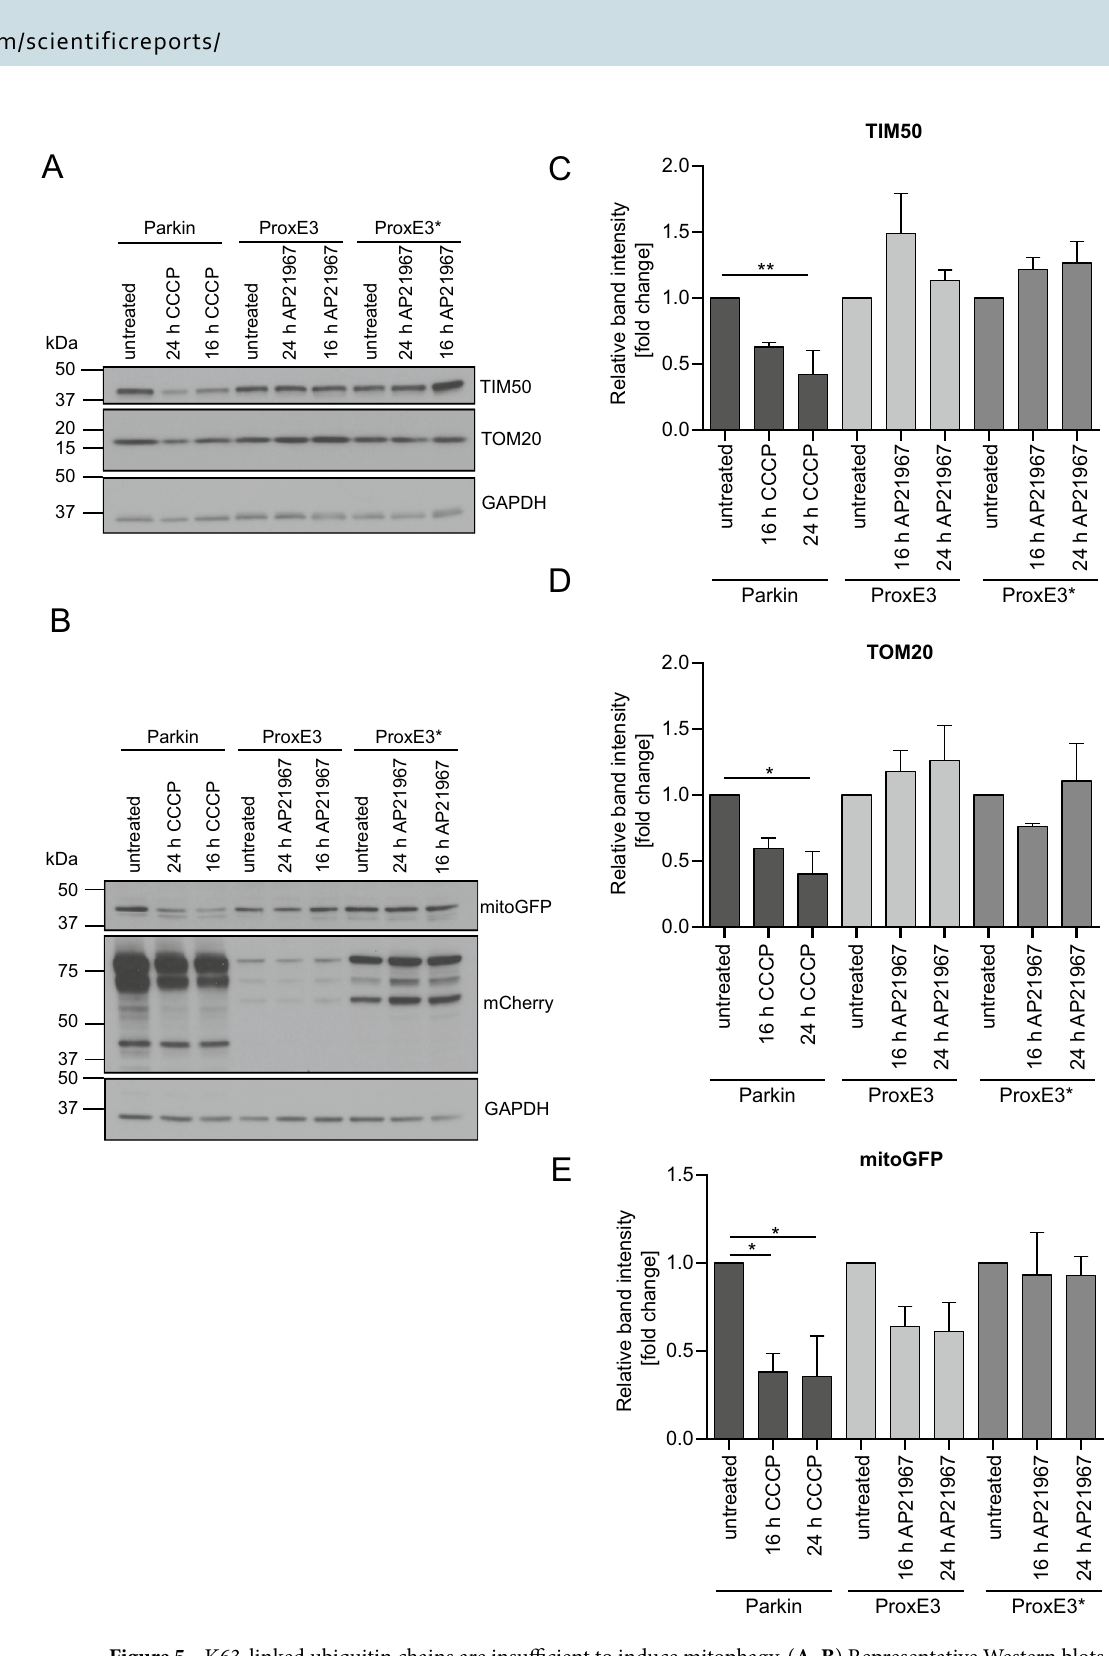
Figure 5. K63-linked ubiquitin chains are insufficient to induce mitophagy. ( A , B ) Representative Western blots of whole cell lysates of HeLa cells stably expressing mitoGFP-Sub transiently transfected with mCherry-Parkin, mCherry-ProxE3 or mCherry-ProxE3*. Cells were either left untreated or were treated for 16 h or 24 h with 10 µM CCCP or 400 nM AP21967. Quantification of the relative band intensities for TIM50 ( C ), TOM20 ( D ) and mitoGFP-Sub ( E ). Data were normalized to the loading control GAPDH and are expressed as fold change compared to untreated cells. Data shown represent the mean ± SEM of three (TOM20, mitoGFP-Sub) or four (TIM50) independent experiments. **p < 0.01, *p < 0.05 (one-way ANOVA, Sidak’s multiple comparison